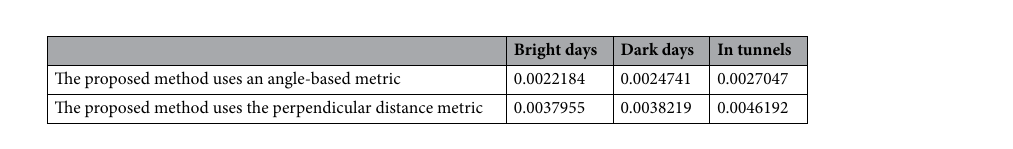
Table 3. Comparison of the proposed method under three lighting